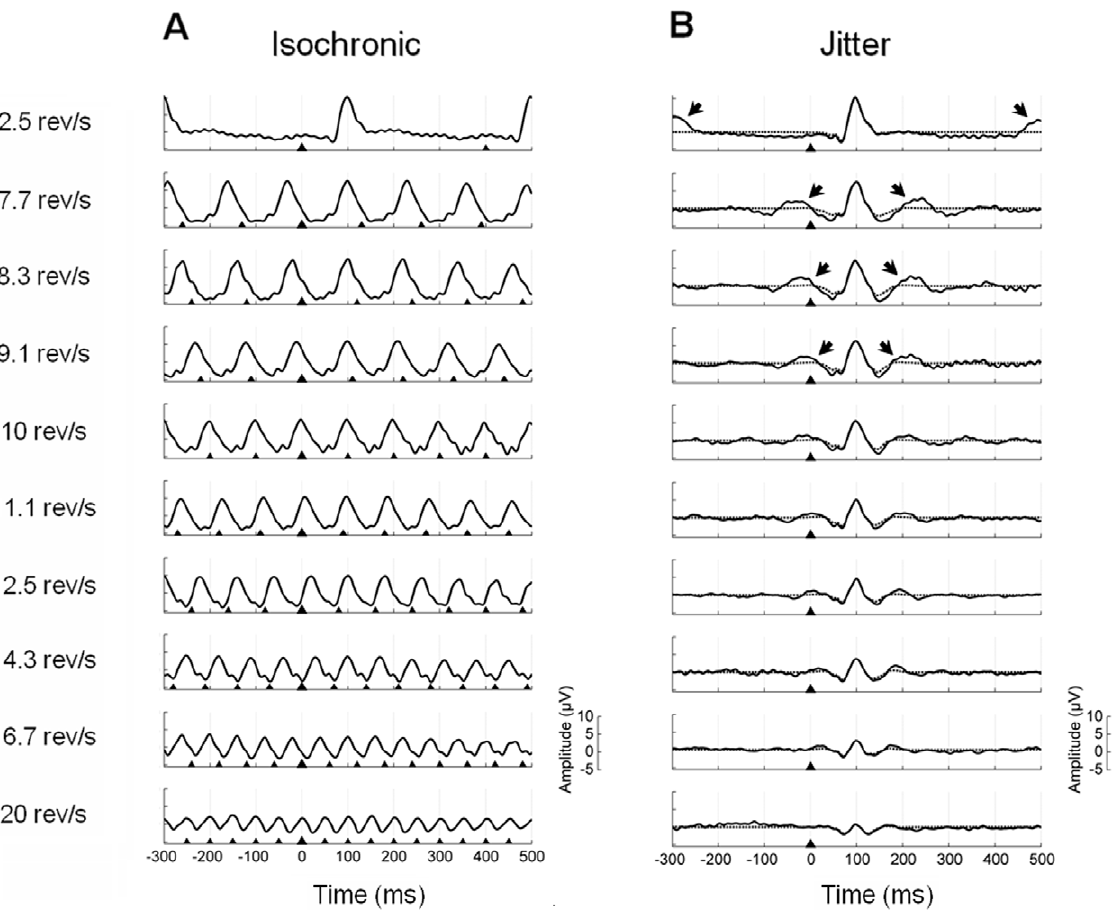
Figure 6. Grand-average waveforms at the Oz lead for both isochronic and jitter conditions (Experiment 2). A , Recorded waveforms (800 ms time window; 300 ms pre-stimulus) for the isochronic stimulation conditions, including one stimulation rate characteristic of transient ERPs (2.5 rev/s) and nine typical SSR reversal rates ranging from 7.7 to 20 rev/s. The triangles indicate stimuli onset; the largest triangle represents the zero time point. B , Grand-average waveforms of the corresponding jitter conditions are shown in solid line. Reminiscent activity from preceding and forthcoming stimuli has been marked by arrows. The Gaussian-modulated waveforms used as transient templates in the synthesis procedure are shown in dashed line.